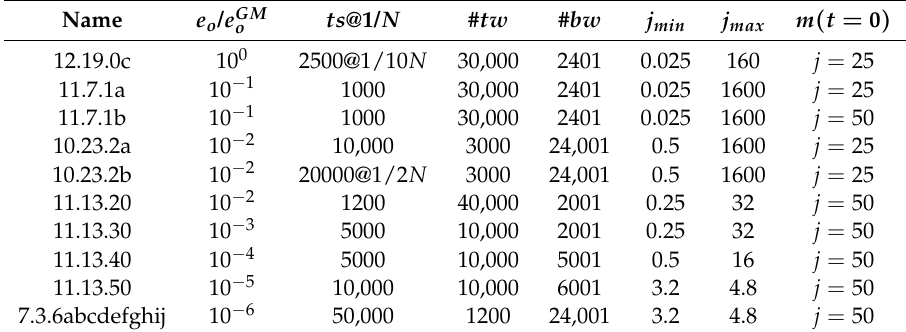
Table A1. Run summary for estimating phase correlations (Figure 6). We create an ensemble of test wave time series by creating multiple realizations (# tw ) of the randomly phased inertial field having # bw constituents uniformly distributed between j min and j max . The length of the simulations are denoted by number of time steps ts at the indicated time